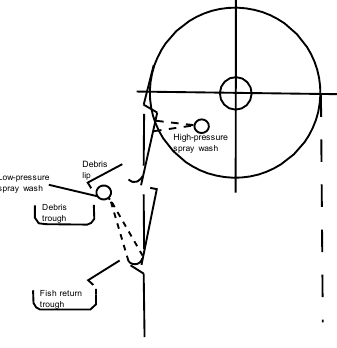
Figure 10. Fish return system adapted from [76].